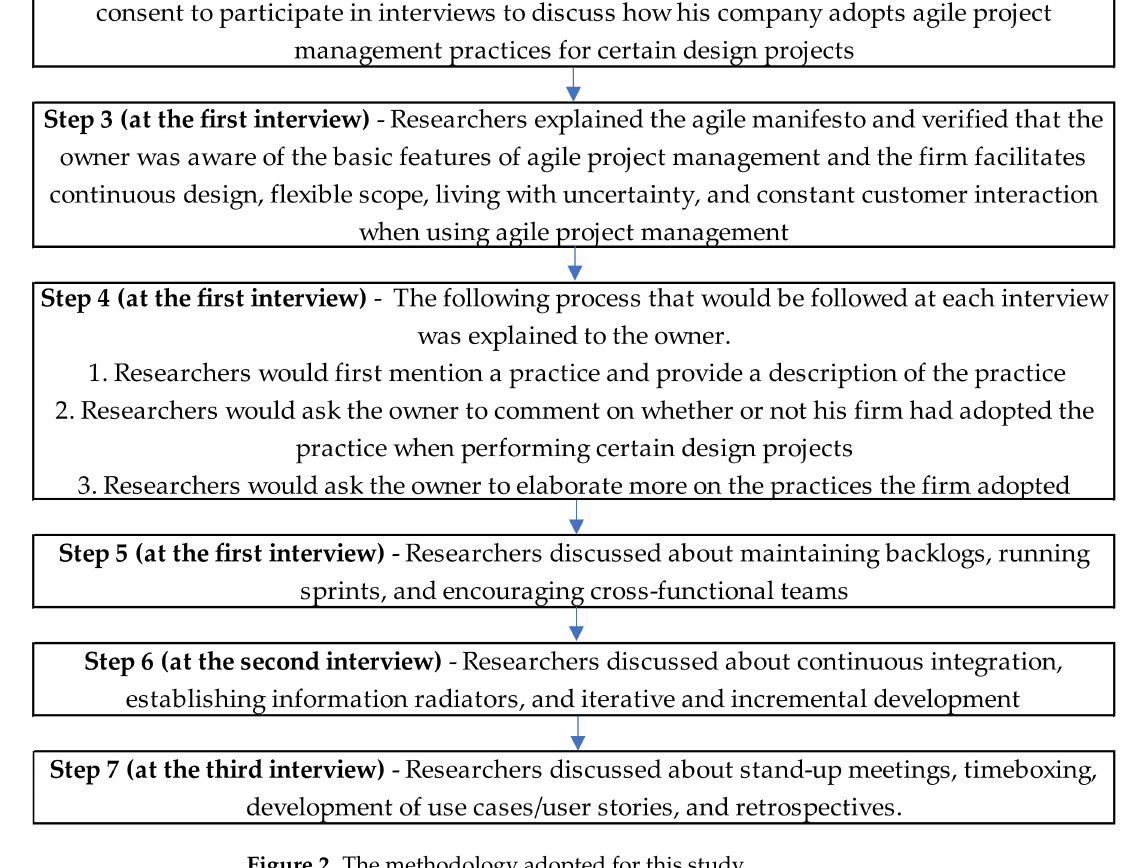
Figure 2. The methodology adopted for this